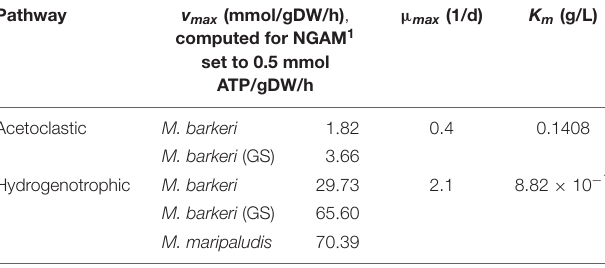
TABLE 2 | Pathway- and model-specific kinetic uptake values.